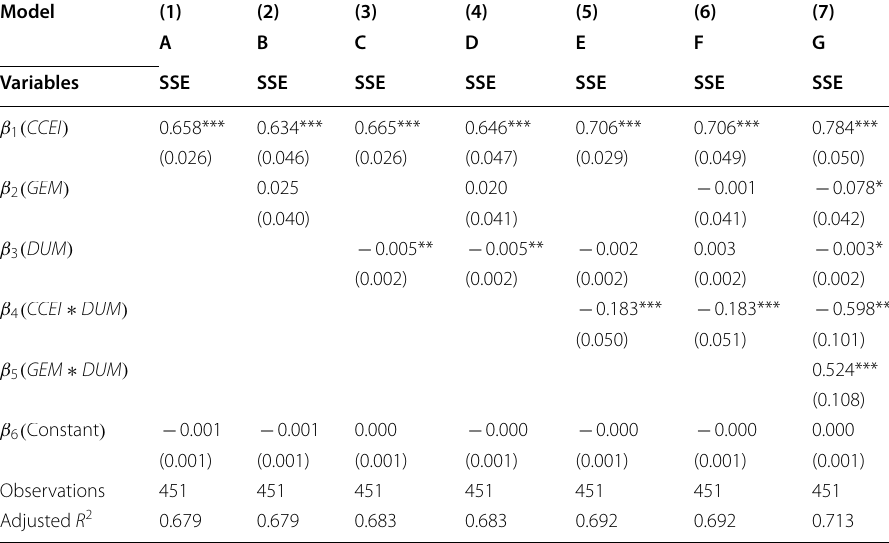
Table 10 Least squares regression of